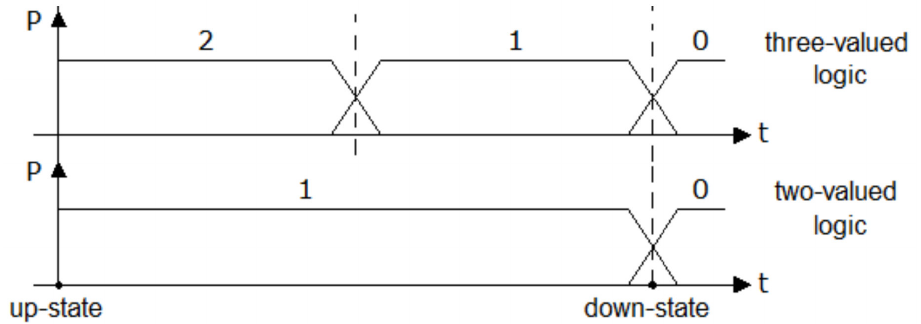
Figure 4. Diagram of the bases of diagnosing based on change to the k-th property of the diagnostic signal, for concluding in three-valued logic